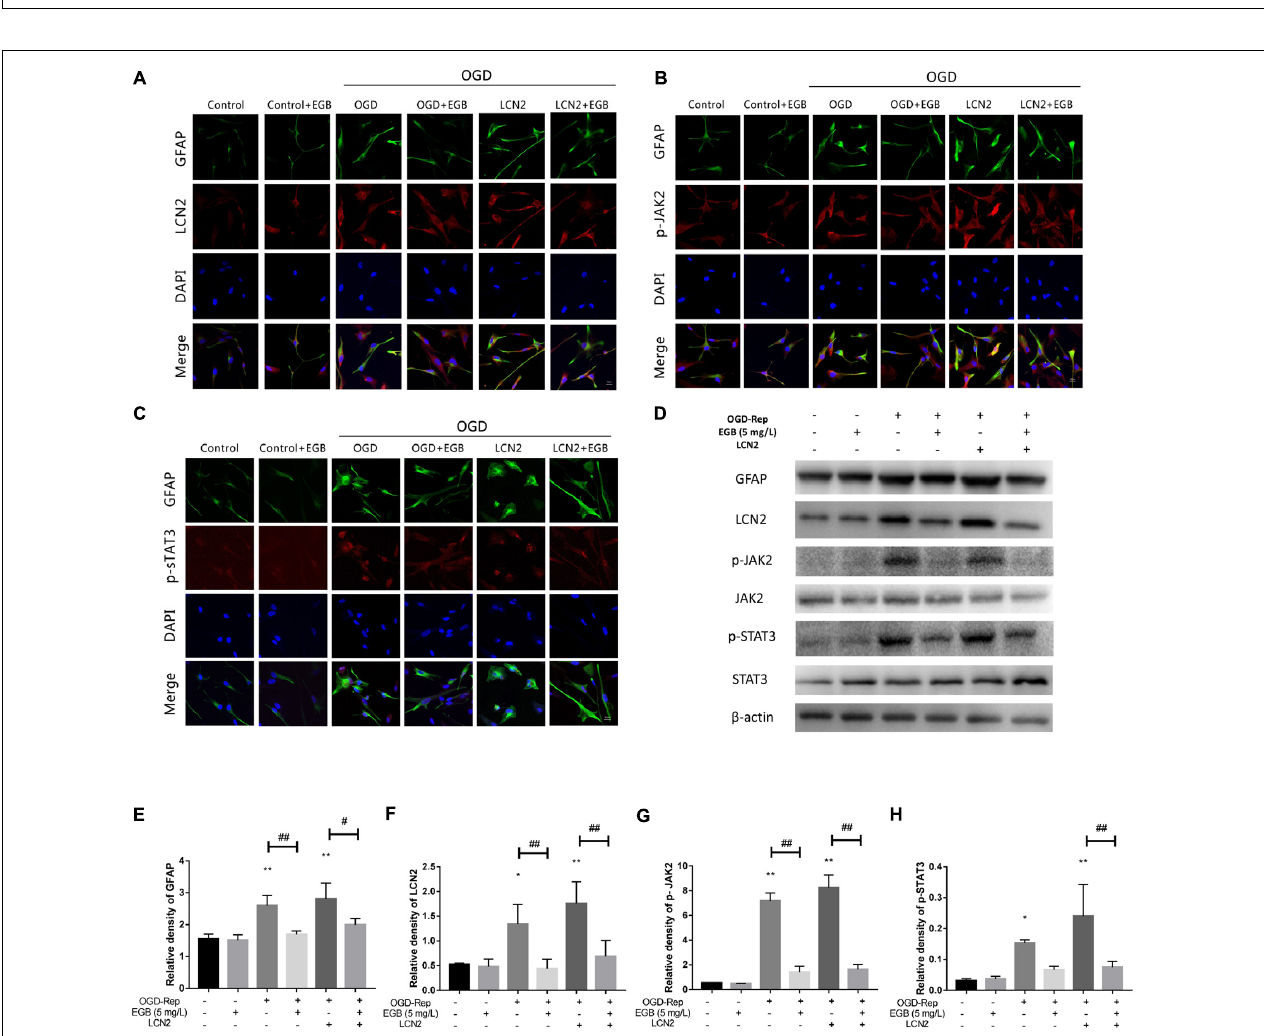
FIGURE 6 | The effects of EGB on the activation of astrocytes and the expression of astrocytic LCN2, p-JAK2, and p-STAT3 after OGD induction in vitro . (A–H) Double-immunofluorescence staining for GFAP, LCN2, p-JAK2, and p-STAT3 in astrocytes after OGD induction. Scale bar = 20 µ m. Western blots and quantitative analysis of GFAP, LCN2, p-JAK2, and p-STAT3 expression. Data are expressed as mean ± SEM ( n = 3). ∗ p < 0.05 and ∗∗ p < 0.01 vs. control group; # p < 0.05 and ## p < 0.01 vs. the indicated groups.